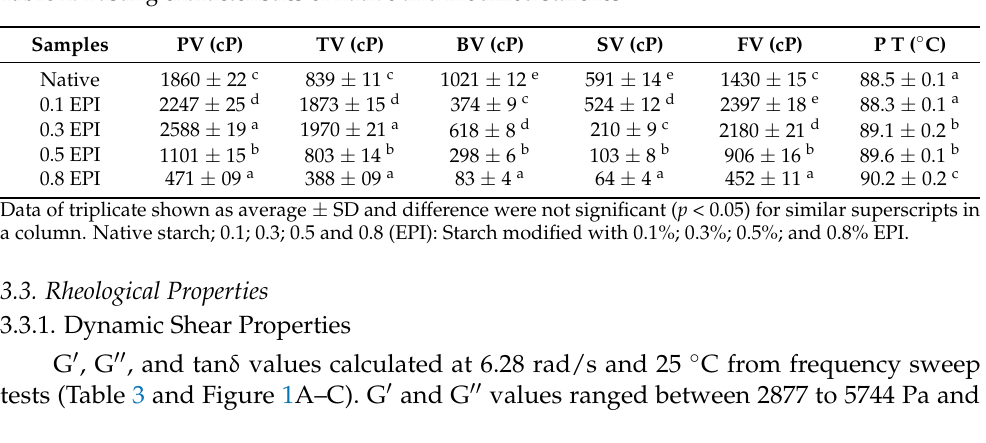
Table 2. Pasting characteristics of native and modified